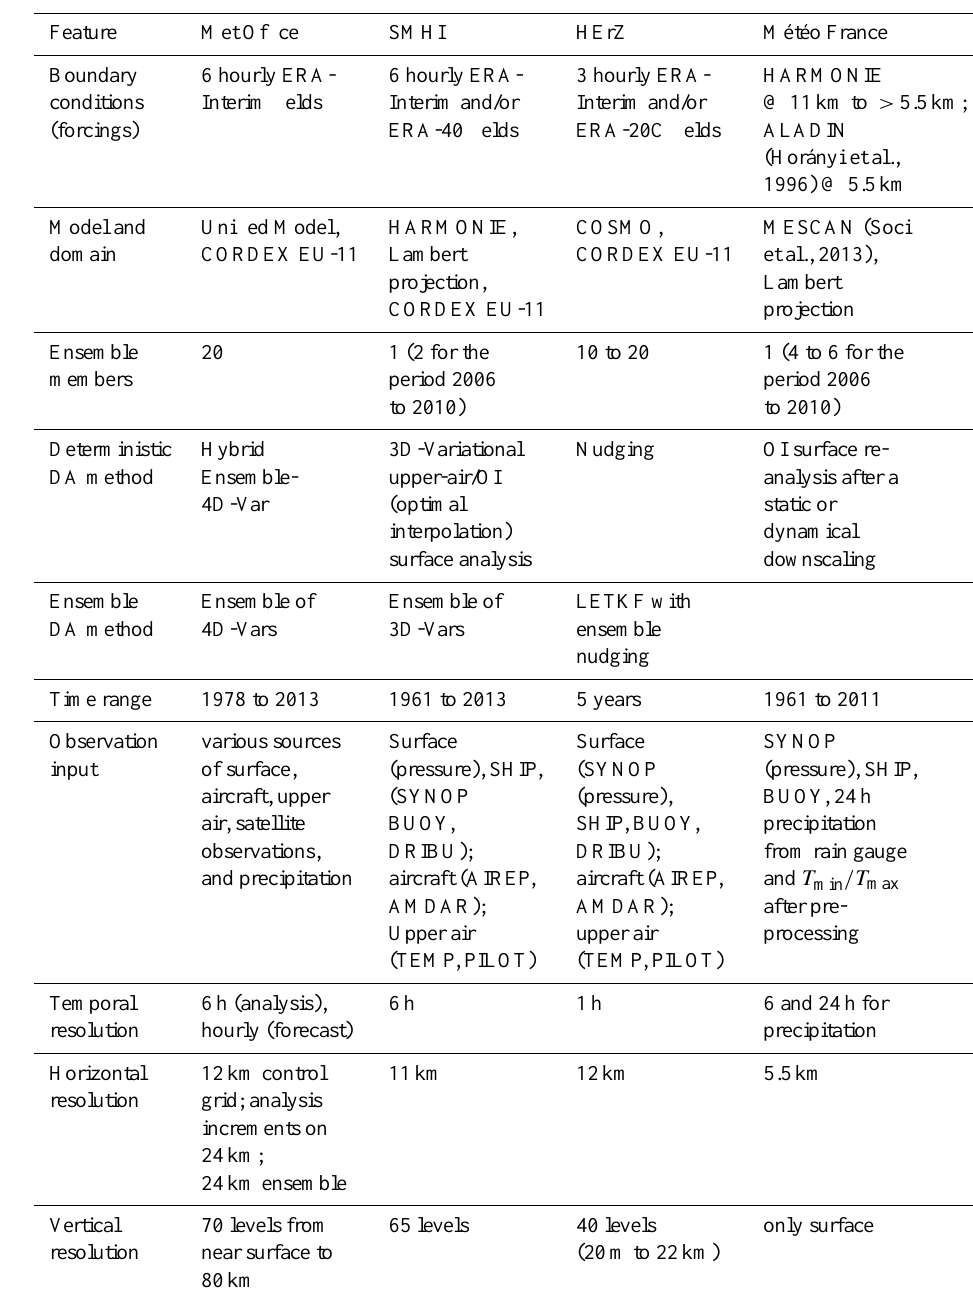
Table 1. Description of the regional reanalysis planned in the UERRA